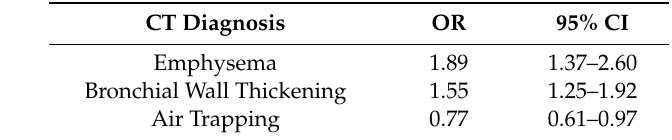
Table 5. Multivariable logistic regression model assessing associations of CT diagnoses with accelerated FEV 1 decline * , †